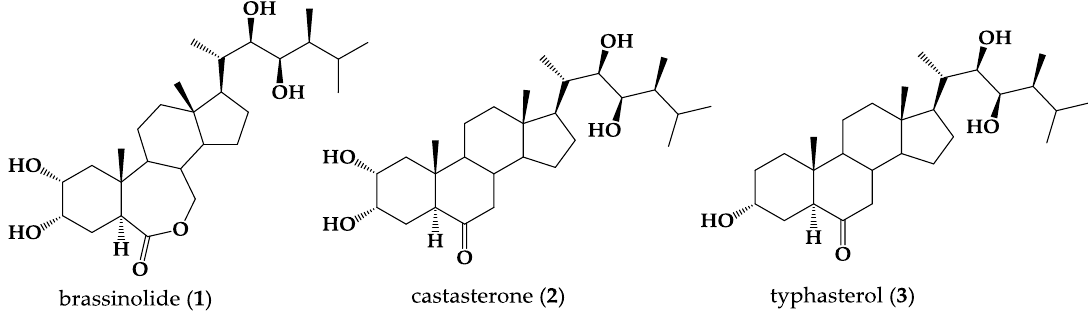
Figure 1. Structure of brassinolide ( 1 ), castasterone ( 2 ) and typhasterol ( 3 ).